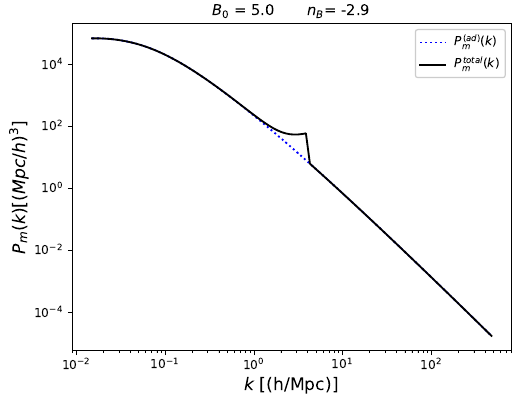
Figure 1. Linear matter power spectrum P total m ( k ) , including the adiabatic mode and the magnetic mode for a magnetic field of strength B = 5 nG and spectral index n B = − 2.9 ( solid line). For comparison ( ad ) ( k ) has also been included ( dotted the pure adiabatic mode P m